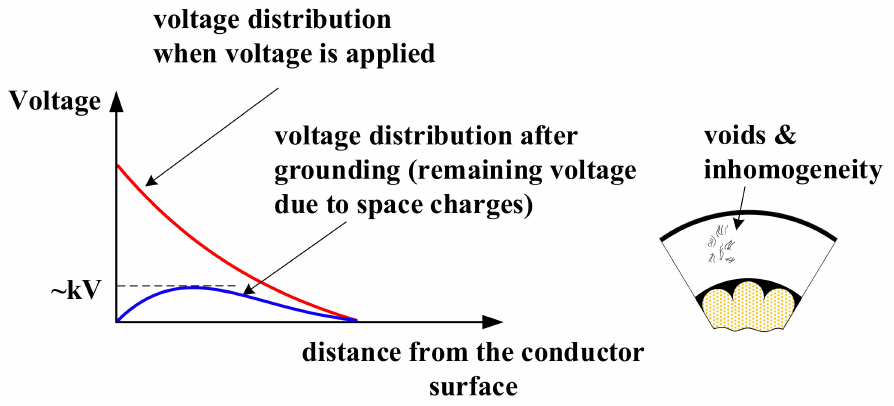
Figure 1. Space charges created in voids of polymeric cables during DC